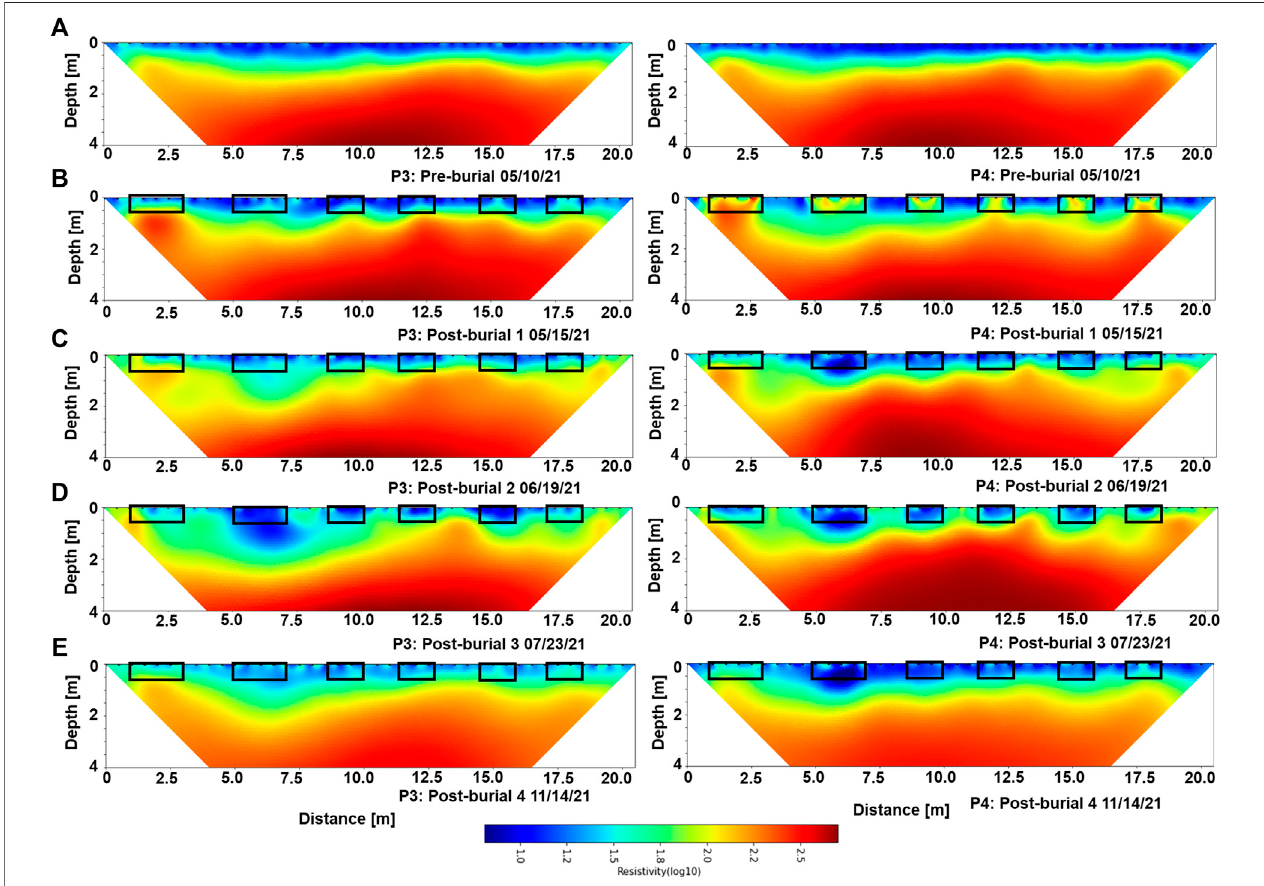
FIGURE 5 | 2D distribution of electrical resistivity across graves for pro fi les 3 (left) and 4 (right). Five different measurements were conducted (A) prior to burial, (B) 2 days after burial, (C) 1 month after burial, (D) 2 months after burial, and (E) 6 months after burial.